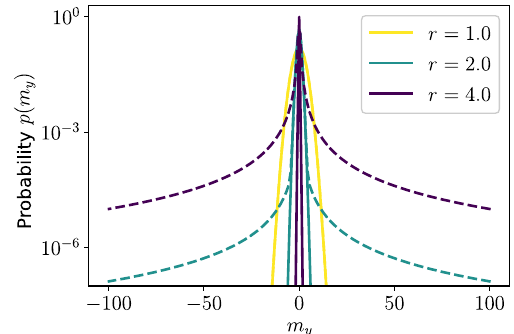
ˆ S probability distribution of the steady state of Eq. (2) y for N ¼ 200 (solid lines) vs N ¼ 201 (dashed lines). The probability distributions for even and odd N differ if the relation e 2 r ≳ N holds. In the limit e 2 r ≫ N , the odd- N distribution develops a fat tail of large